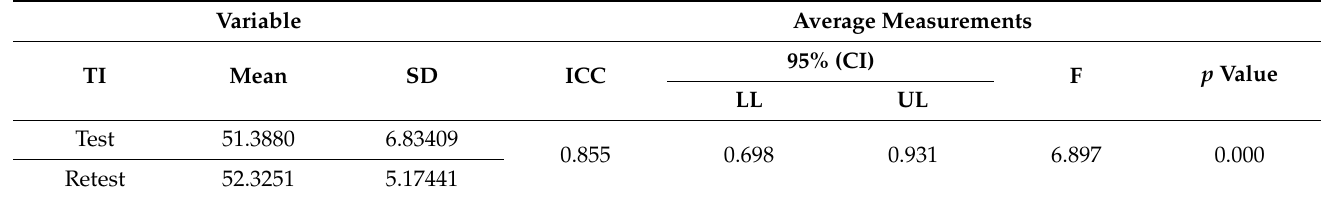
Table 5. Values in the ICC in the test–retest assessment of Total Index (TI) and average measurement.